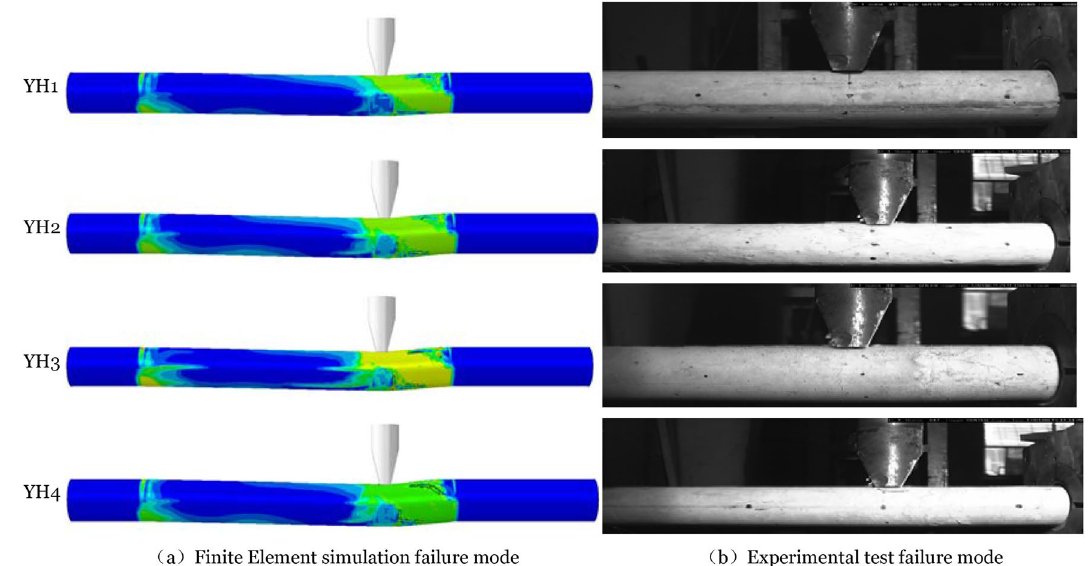
Figure 5. Compares the failure modes chart of the 0.8 ms test process.